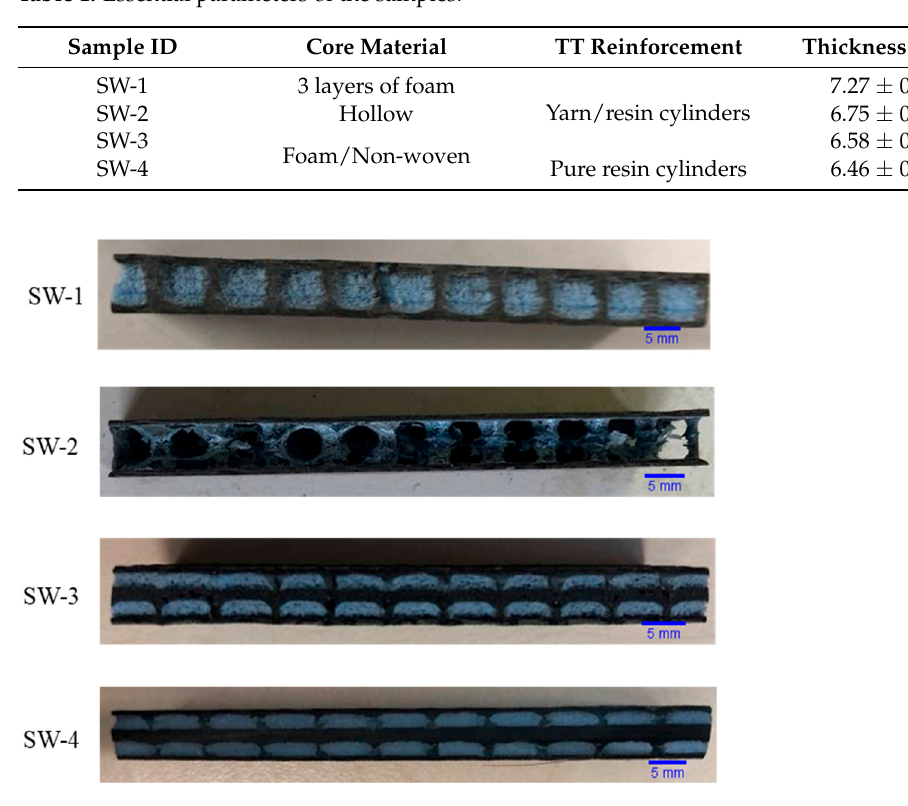
Figure 2. Photos of different sandwich structures.